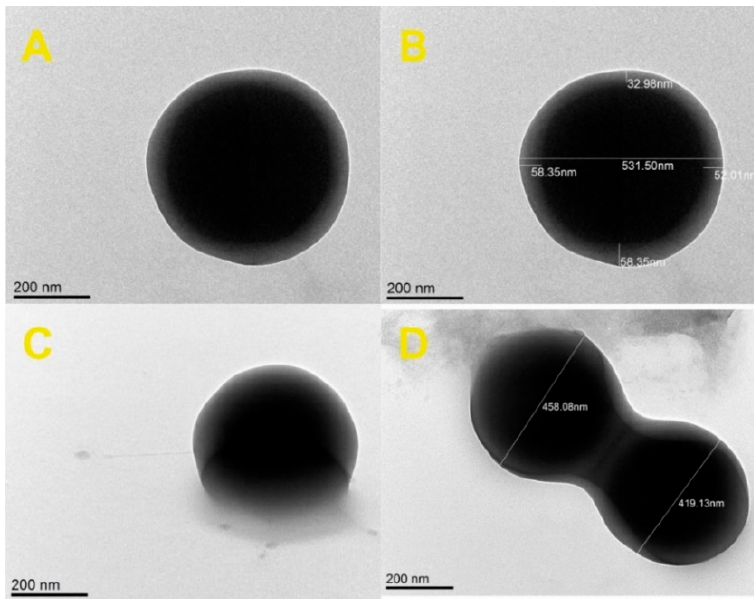
Figure 4. TEM images of HFBMA (H27) particles: single particle ( A ), the same single particle with dimensions ( B ), single particle image taken at +57 °( C ), particle twins ( D ).